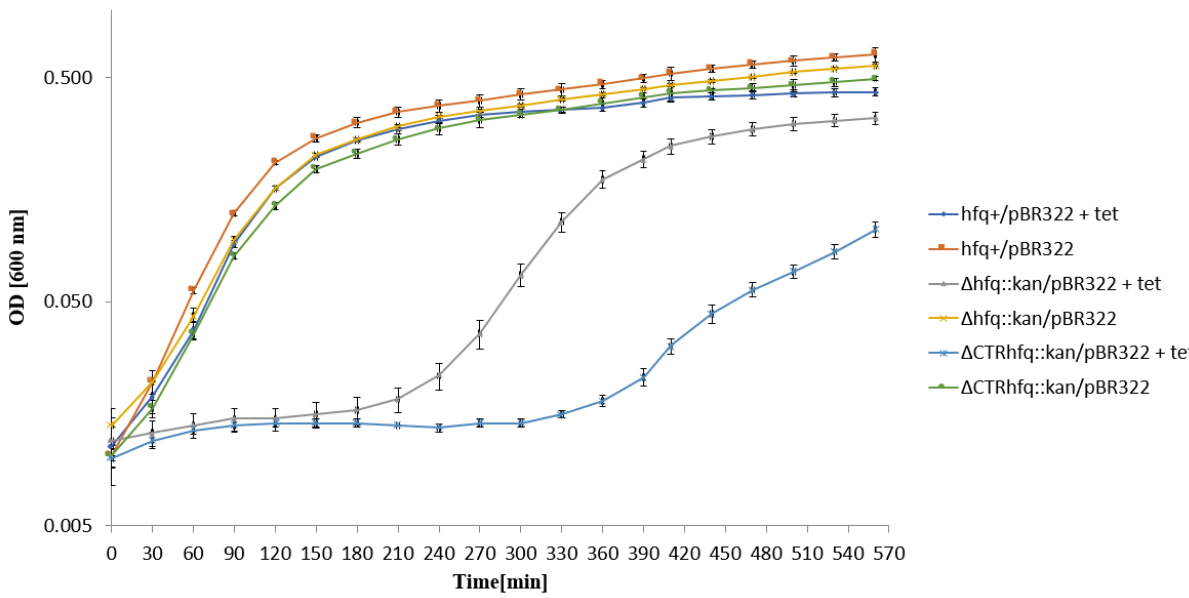
Figure 6. Growth of E. coli strains hfq + , ∆ hfq :: kan , and ∆ CTR hfq :: kan bearing plasmid pBR322 in the LB liquid medium containing 68 µ g/mL tetracycline (+tet) or devoid of this antibiotic (no mark) at 37 ◦ C, after transferring bacteria from antibiotic-free LB and diluting the culture 10 times in a fresh LB medium (with or without tetracycline) at time 0. The presented data indicate mean values from three independent experiments with error bars showing SD. Minimal inhibitory concentrations (MIC) of tetracycline for hfq + , Δ hfq :: kan , and Δ CTR hfq :: kan hosts bearing pBR322 under these conditions were 512, 256, and 1024 μ g/mL, respectively.